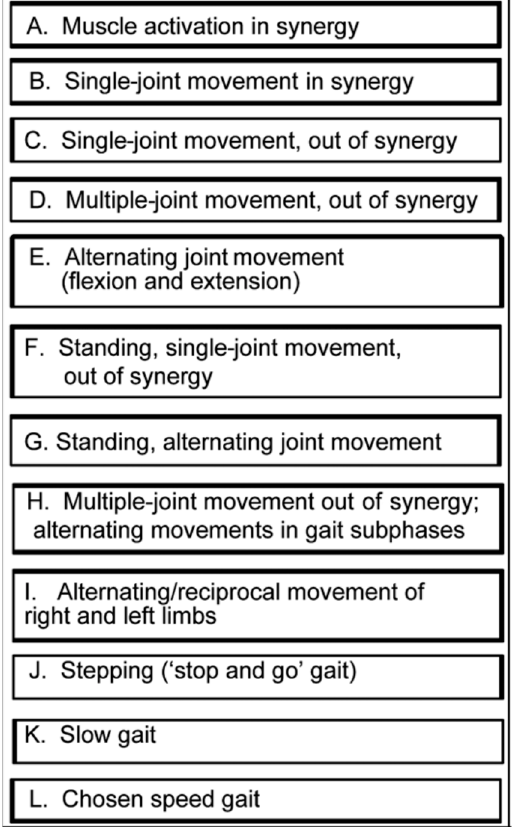
Figure 1. Motor Task Hierarchy for Limb and Gait Coordination Training. Key: In Synergy: with all the given limb joints flexed or all the limb joints extended. Out of Synergy: with at least one joint flexed while all other joints in the limb are extended. Stop and Go Gait: Practice of one subphase of the gait cycle several times in place, before moving forward through that subphase of the gait cycle. Gait subphase: Swing and Stance Phases divided into subphases such as heel-off to toe-off.